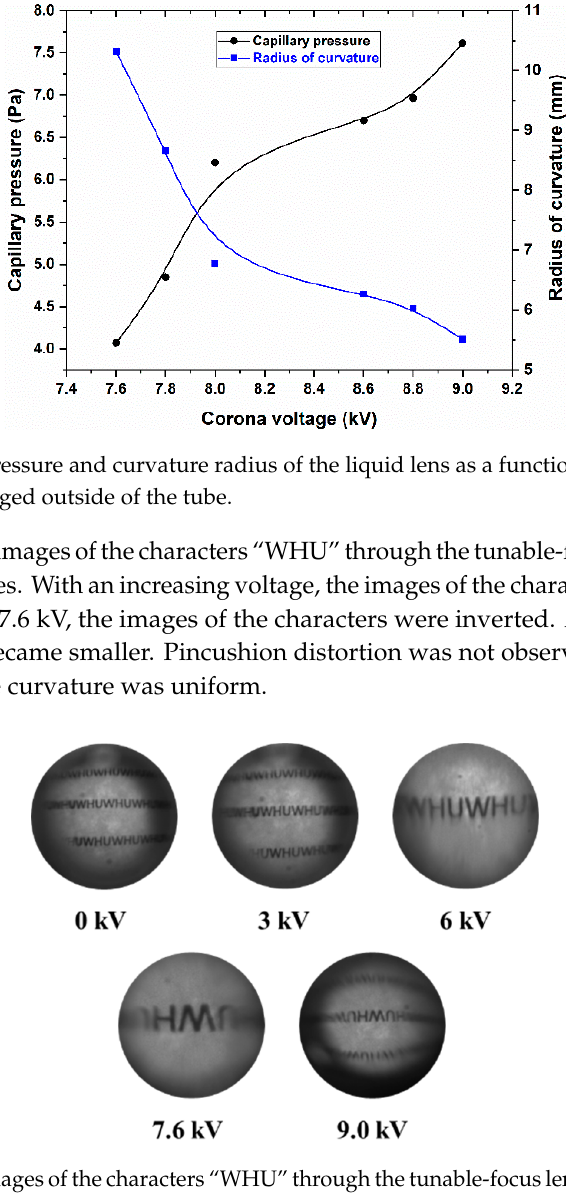
Figure 7. Recorded images of the characters “WHU” through the tunable-focus lens at different voltages.